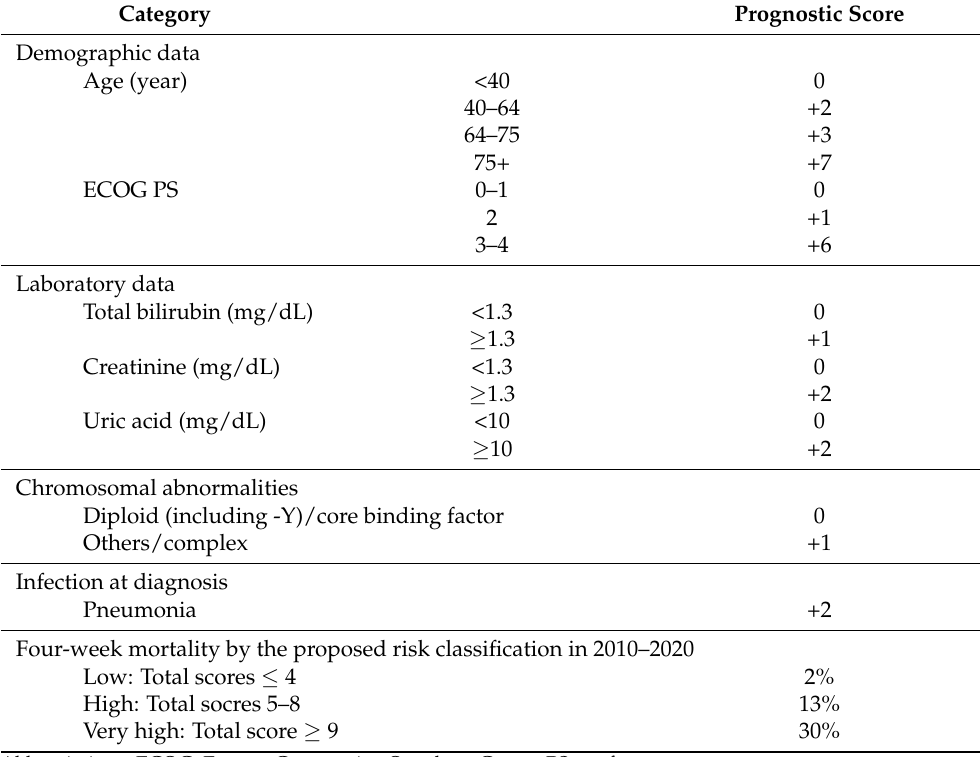
Table 1. Proposed prognostic risk scoring for 4-week mortality and risk classification (modified)